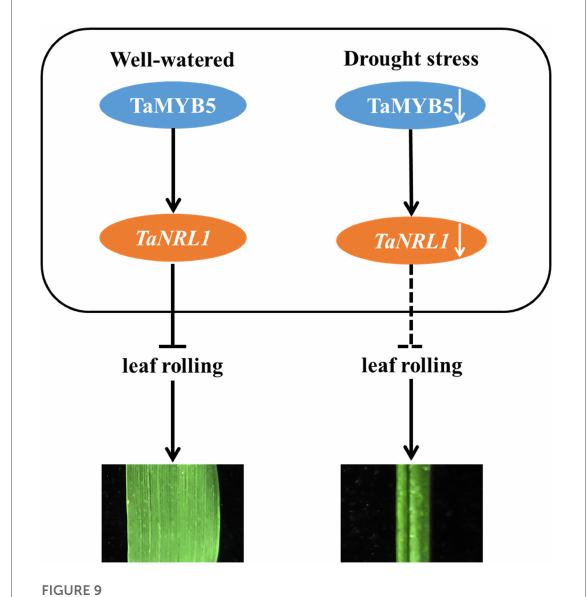
FIGURE9 A proposed model for the TaMYB5 gene in the regulation of adaxial rolling of leaf. Under well-watered, TaNRL1 was expressed normally and inhibited leaf rolling and leaves showed a flat state. Under drought stress, the expression of TaNRL1 decreased along with the decrease of TaMYB5 , which reduced its ability to inhibit leaf rolling. The promoting role is represented by → , and (cid:97) shows the inhibiting